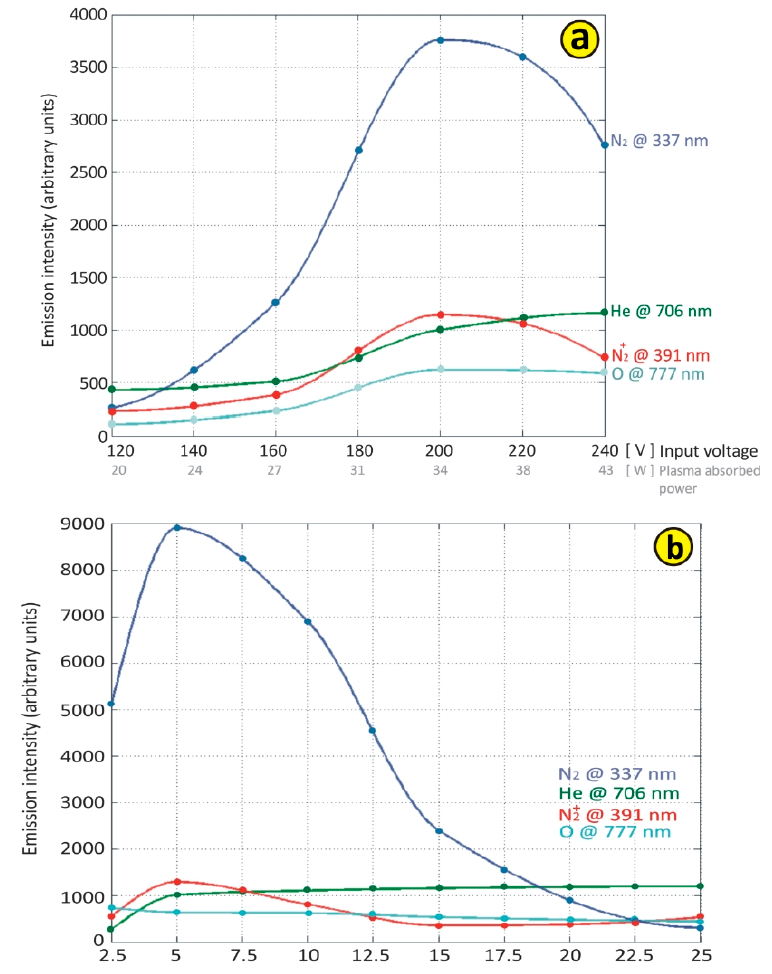
Figure 5. ( a ) The evolution of the emission of the molecular and atomic species generated in the plasma discharge as a function of the input voltage/power. ( b ) The dependence of the emission intensities as a function of the feed gas flow rate.